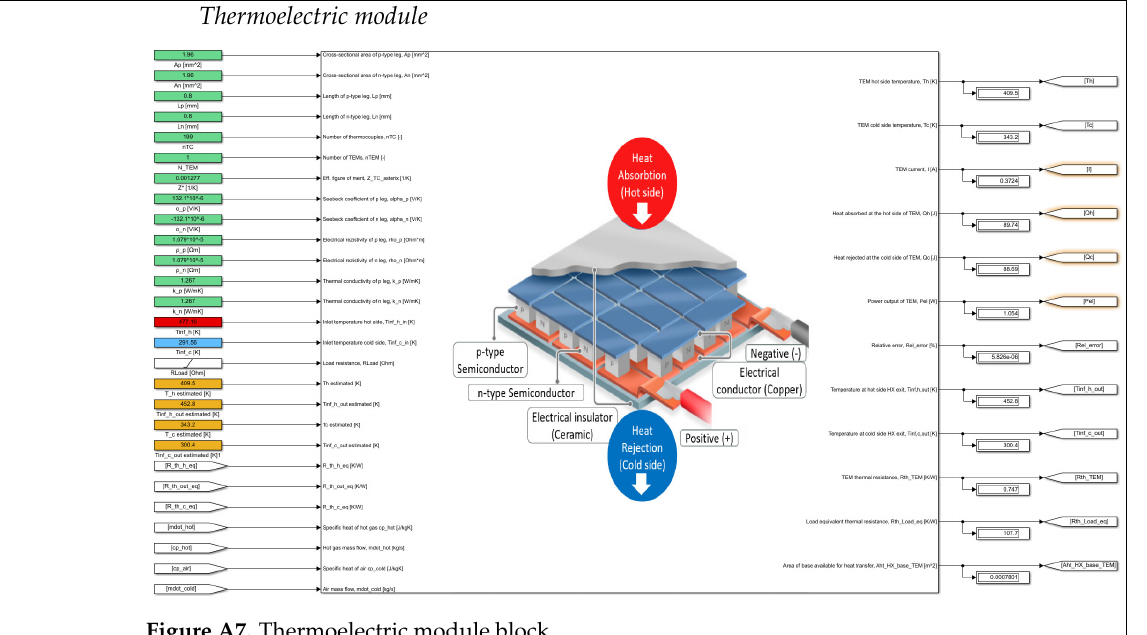
Figure A7. Thermoelectric module block.